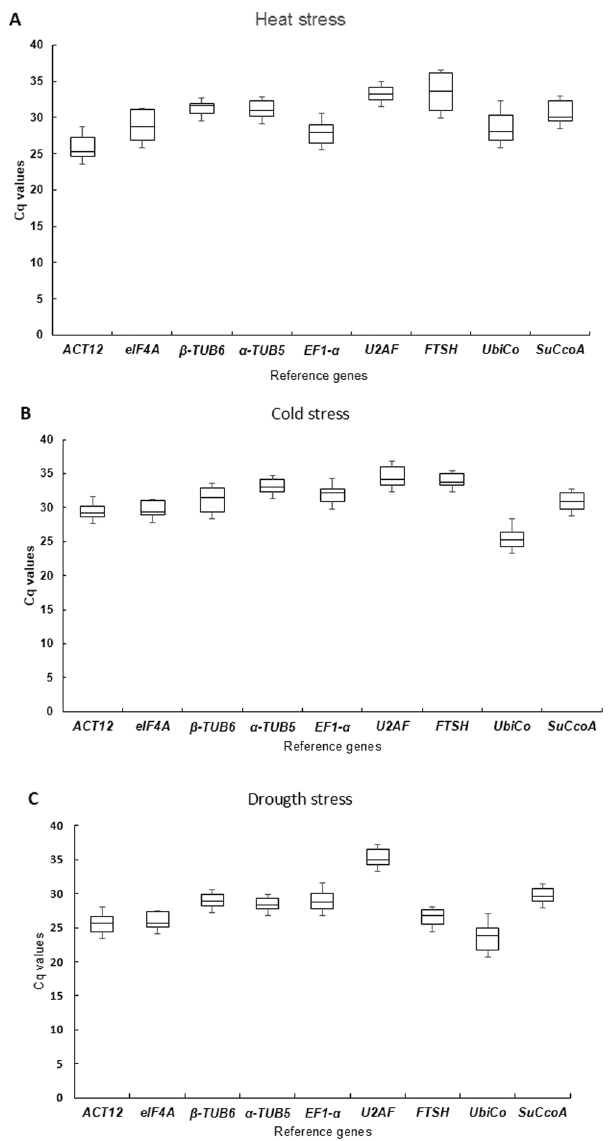
Figure 3. Average of Cq values of the candidate reference genes for each stresses: A –heat, B- cold and C – drought stress, with a total of 12 samples for each gene. Box-plot graph shows the median values as lines across the box. Lower and upper boxes indicate the 25th percentile and 75th percentile, respectively. Whiskers represent the maximum and minimum